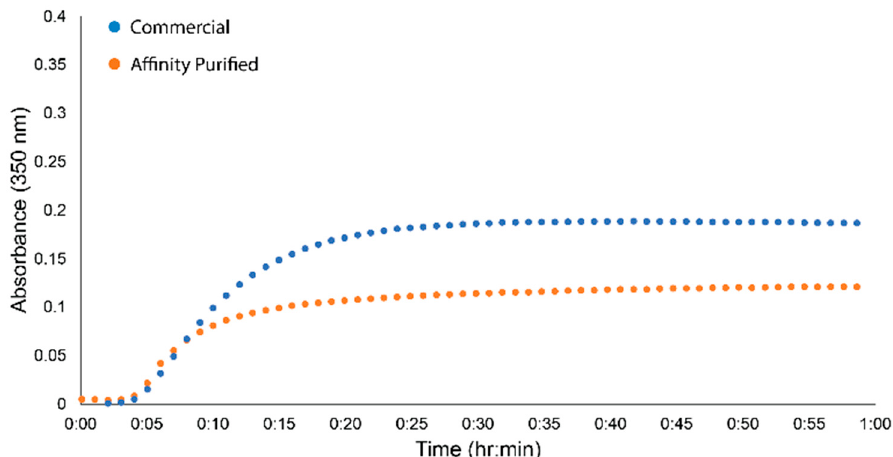
Figure 5. Turbidity of fgn isolated from FFP using GPRPFPAWK affinity column. Representative turbidity traces from commercial samples (blue) and affinity purified samples (orange).